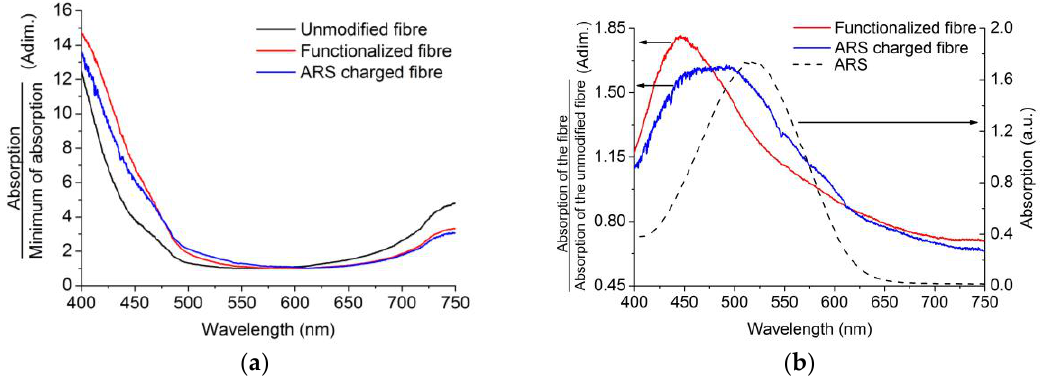
Figure 8. Normalized absorption curves of different probes: ( a ) unmodified, functionalized, and ARS-charged fibers; ( b ) absorption curve of functionalized and ARS-charged probe normalized with the unmodified probe and the absorption curve of ARS.